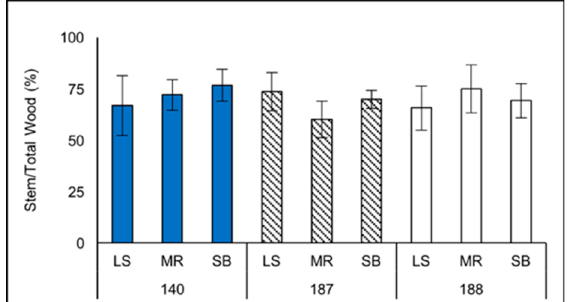
Figure 2. Biomass-based percentages of stem wood (from the total tree wood) for three sampled clones (140,187, and 188) sampled from stands located in the upper Blue Ridge Mountains (LS), the lower Blue Ridge Mountains (MR), and the Piedmont (SB) of North Carolina.